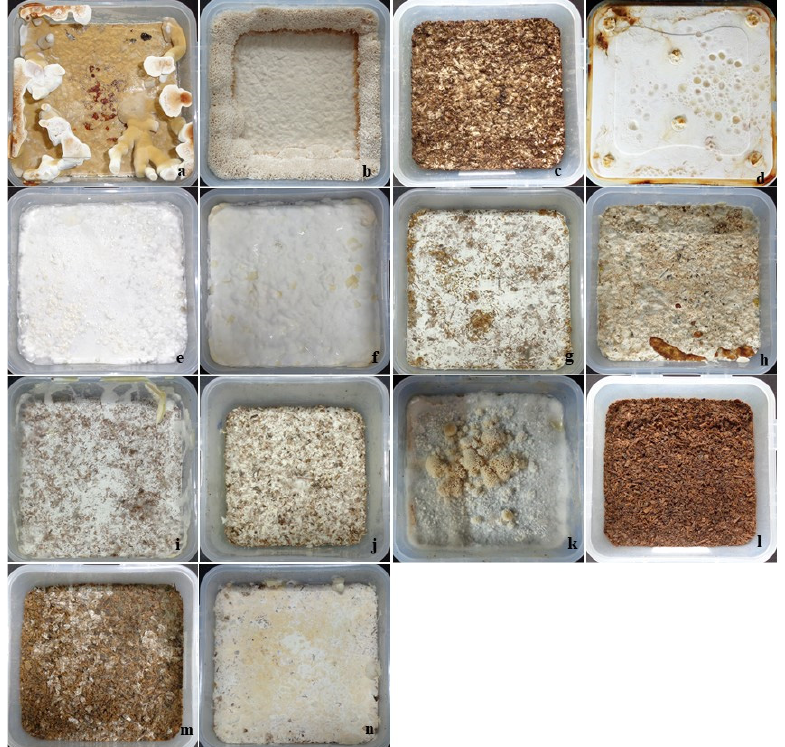
Figure 2. Topography of the mycelial mat generated from the Polyporales species. ( a ) Ganoderma lucidum , ( b ) G. applanatum , ( c ) Elfvingia applanate , ( d ) Fomitella fraxinea , ( e ) Formitopsis pinicola -JF, ( f ) F. pinicola -KCTC, ( g ) F. rosea , ( h ) Trametes versicolor , ( i ) T. hirsuta , ( j ) T. suaveolens , ( k ) Wolfiporia extensa , ( l ) Microporus affinis , ( m ) Bjerkandera adusta , ( n ) Postia balsamea .